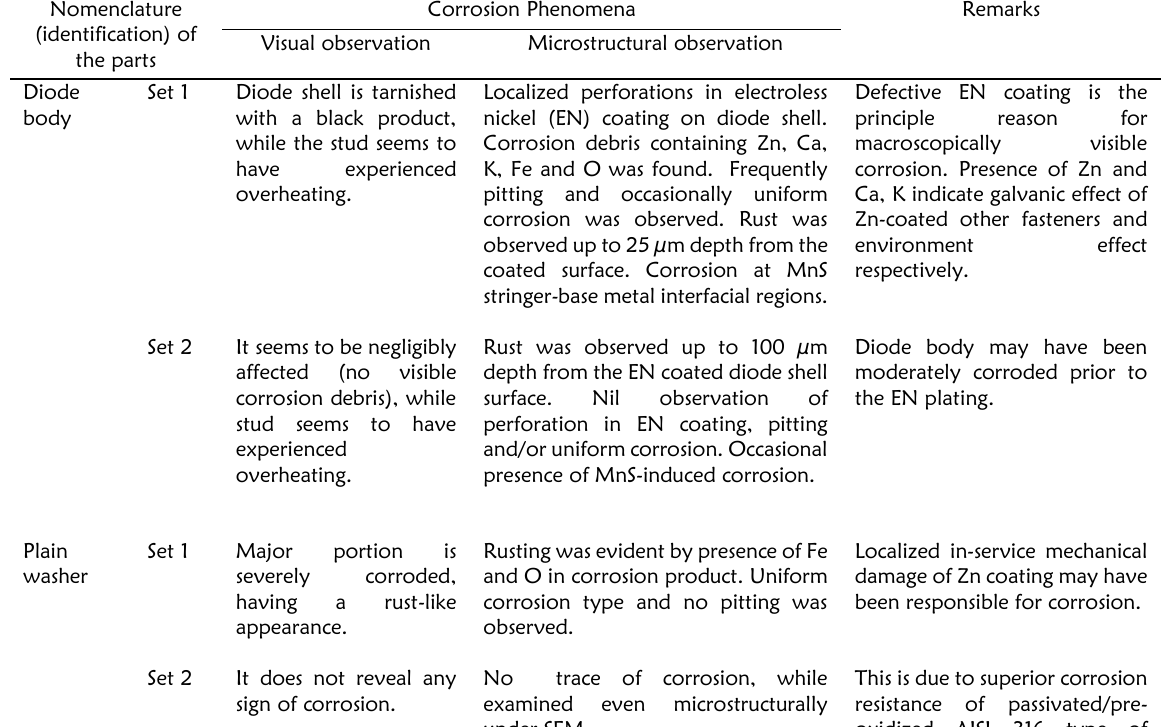
Table 4: Nature of corrosion types of various fasteners of two diode assemblies in comparative mode